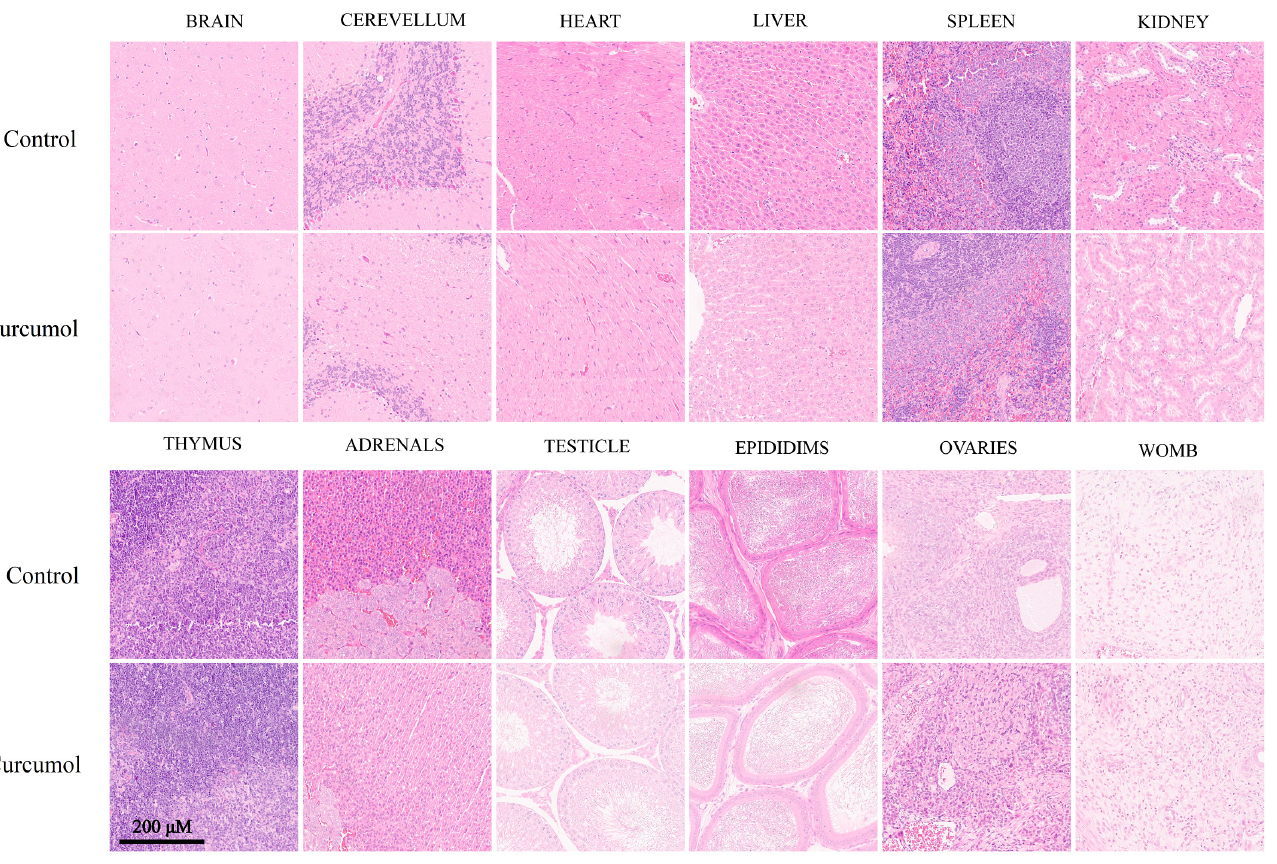
Figure 2. H&E stained sections of brain, cerebellum, heart, liver, spleen, kidney, thymus, adrenals, testicle, epididims, ovaries, and womb from SD rats treated with control and curcumol (1000 mg/kg/day) for 28 days (scale bar: 200 µ m).